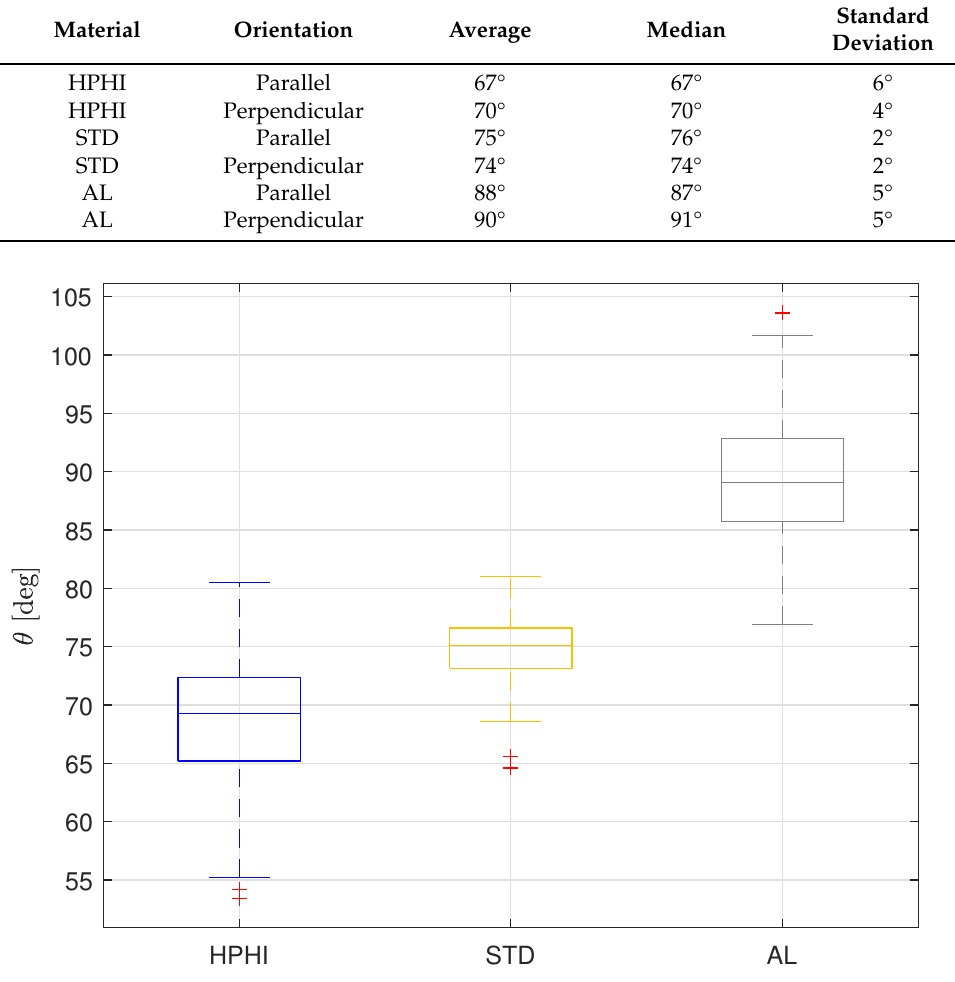
Figure 4. Boxplot representing the overall static contact angles for each of the three surfaces: HPHI in blue, STD in yellow, AL in